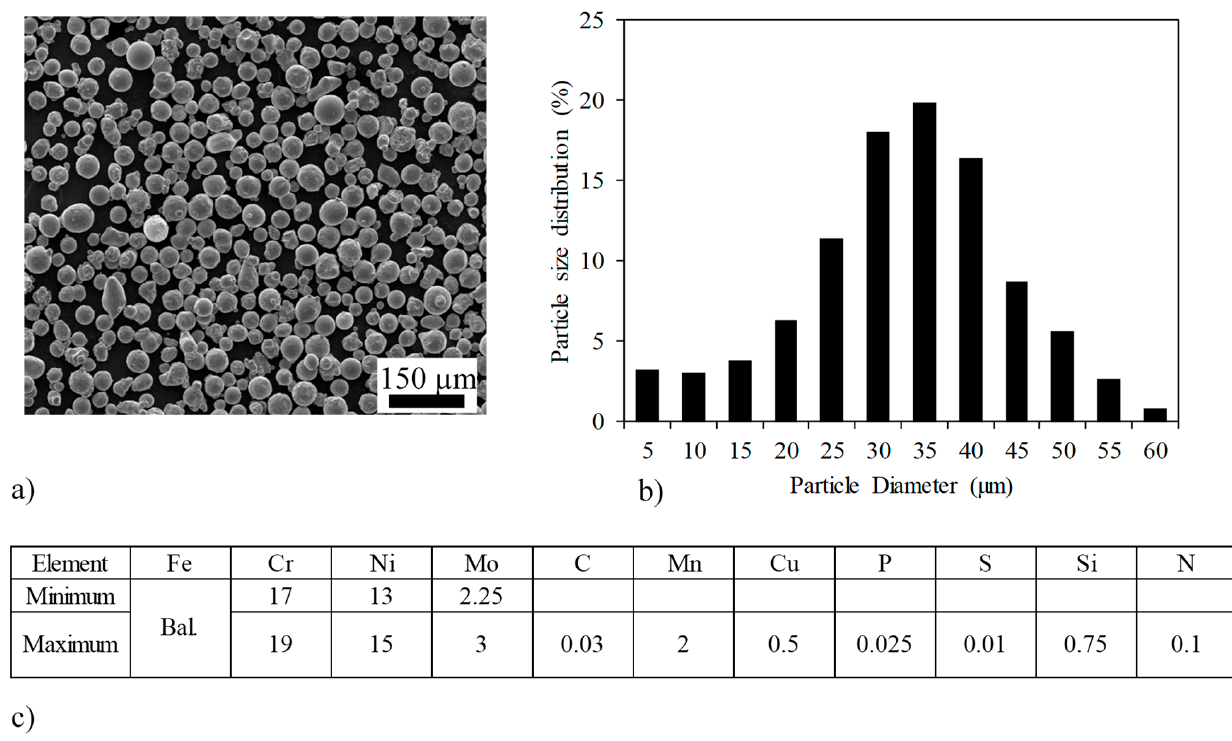
Figure 4. 316L Stainless steel powder analysis. ( a ) SEM image showing the shape and size of the powder. ( b ) Particle size distribution histogram. ( c ) Chemical composition of the used stainless steel 316L powder.